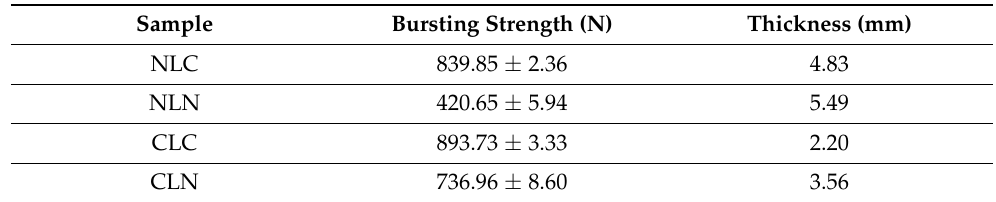
Figure 5. Bursting strengths of the NLC, NLN, CLC, and CLN composites. Table 3. Bursting